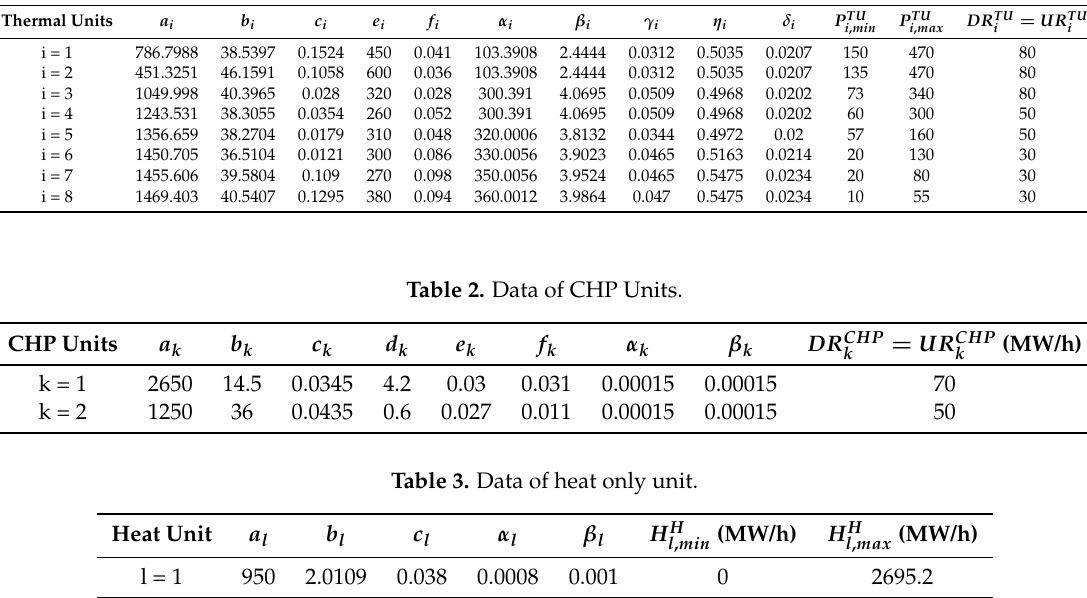
Table 1. Data of thermal units.